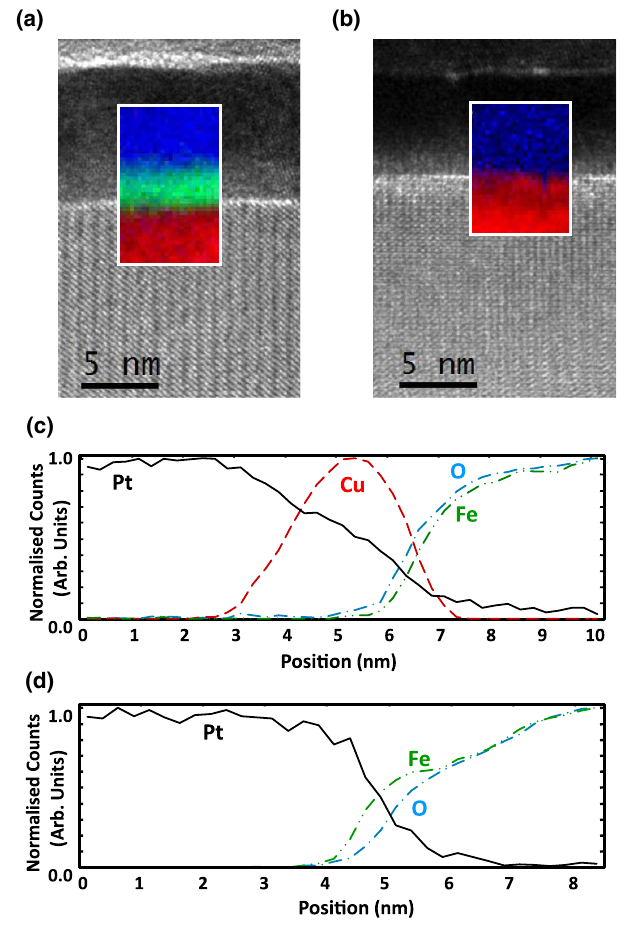
FIG. 5. Electron microscopy analysis of (a),(c) Pt/Cu/YIG and (b),(d) Pt/YIG samples. (a),(b) TEM images of the YIG (lower) and metallic layers with (inset) colored panels indicate the distributions of (red) Fe, (green) Cu, and (blue) Pt across the interface. Elemental maps are generated by EELS in scanning- TEM mode in similar areas to those indicated. Integrated, normalized signal intensities across the data sets suggest changes in the interfacial structure (see text for